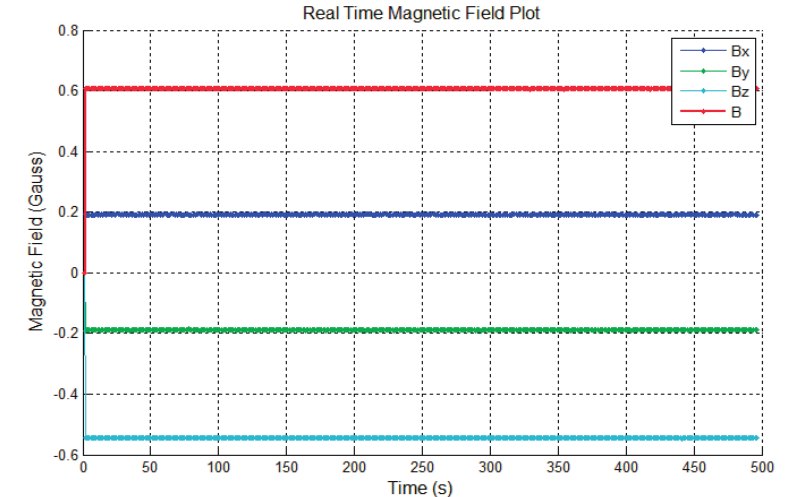
Figure 10. Sensor data after calibration.